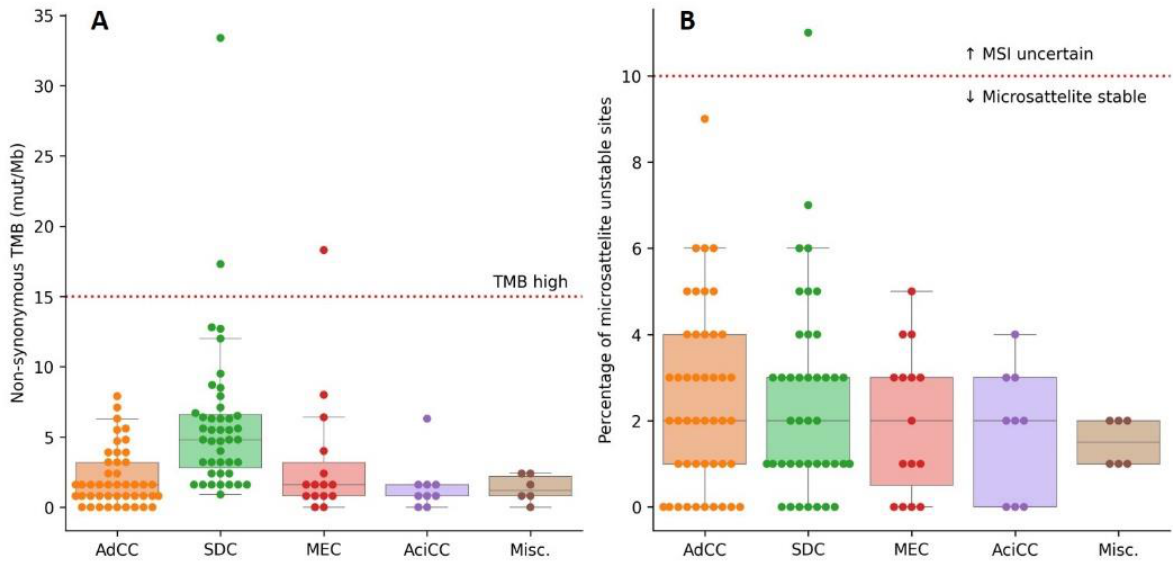
Figure 4. ( A ): Non-synonymous tumor mutational burden (TMB), sorted per subtype. ( B ): per- centage of microsatellite instable sites (MSI), sorted per subtype. Dotted lines indicate thresholds for tumors with high TMB and with potential MSI. Abbreviations: SDC: salivary duct carcinoma, AdCC: adenoid cystic carcinoma, MEC: mucoepidermoid carcinoma, AciCC: acinic cell carcinoma, misc.: